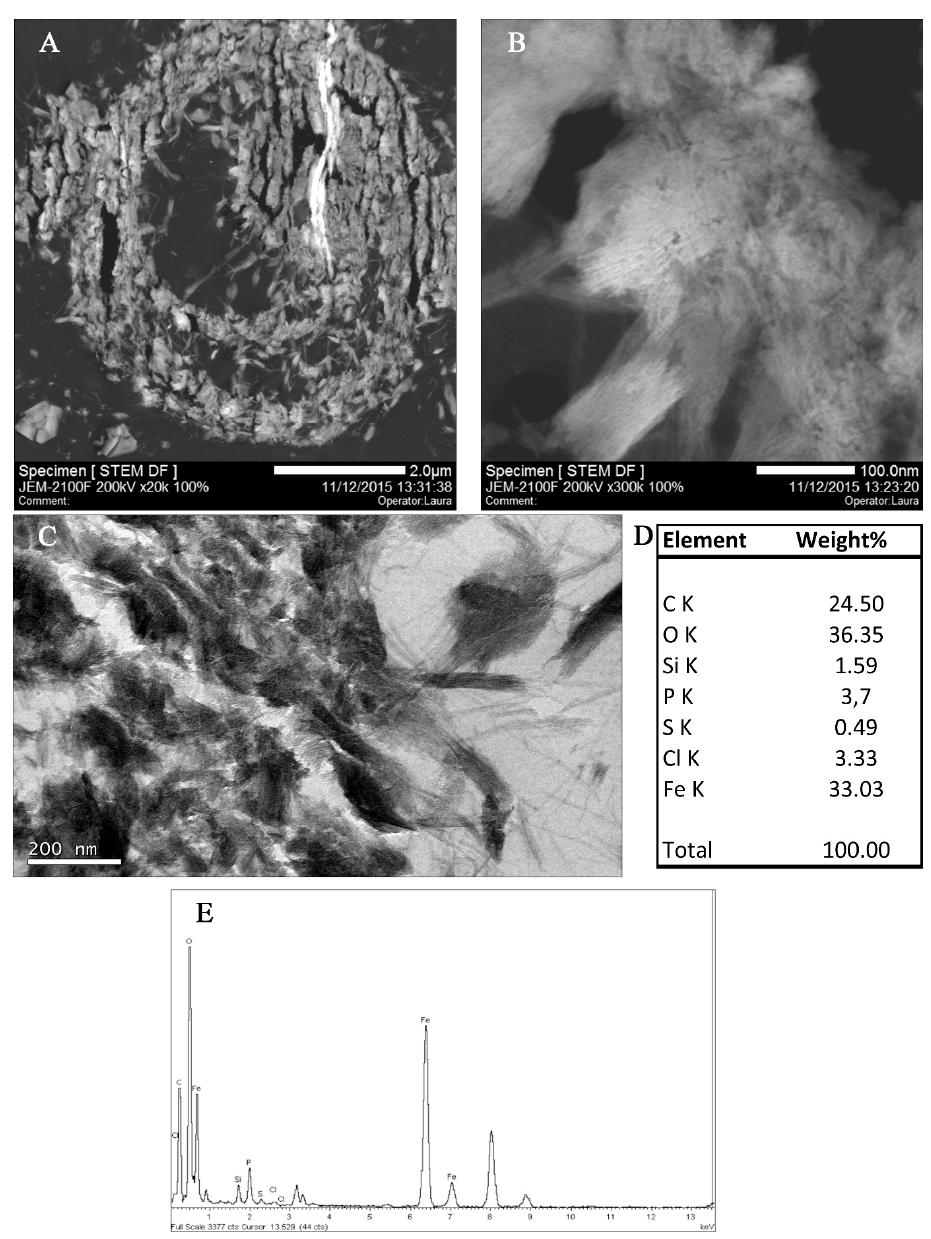
Figure 5. ( A ) HAADF-STEM image of Figure 4C; ( B ) HAADF-STEM image of a section of Figure 5A; ( C ) TEM image of a section of Figure 5A; ( D ) Quantitative analysis of Figure 5C; ( E ) EDX spectrum of Figure 5C.